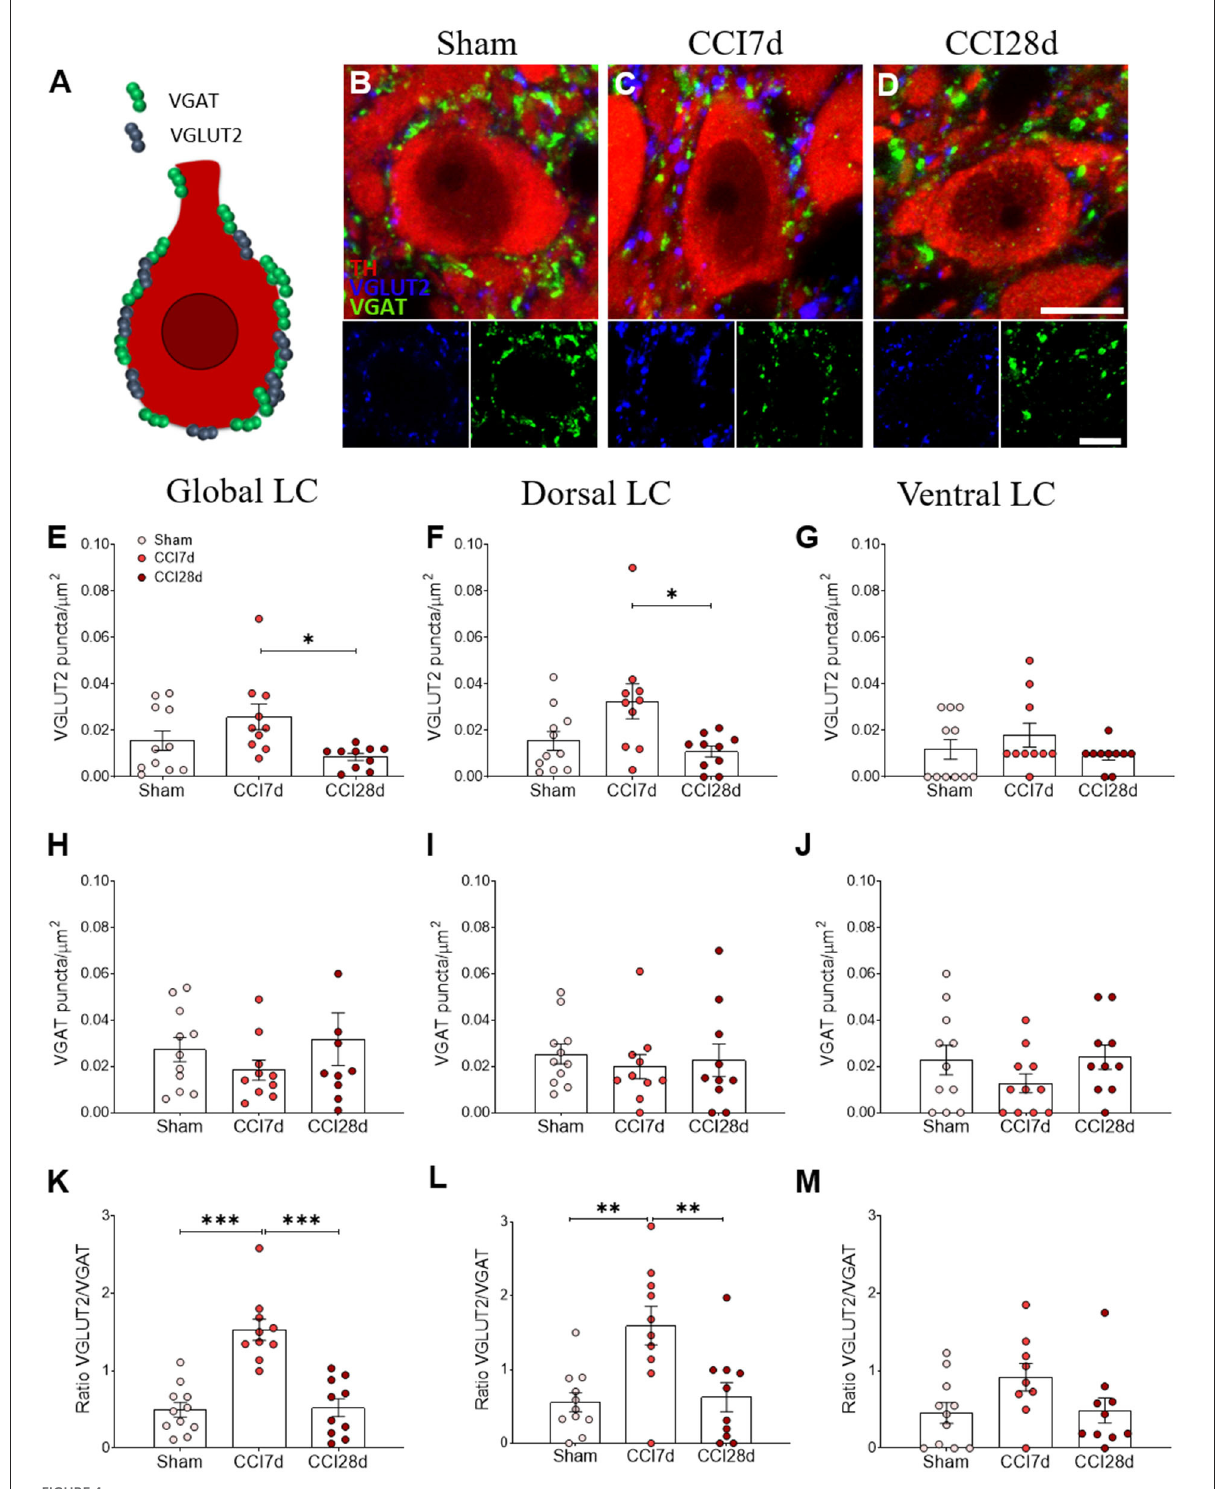
FIGURE4 Perisomatic puncta expressing VGLUT2 and VGAT in LC neurons of neuropathic pain rats. (A–D) Representative confocal images showing perisomatic density of puncta expressing VGLUT2 and VGAT in the LC of (B) Sham, (C) CCI7d, and (D) CCI28d rats (TH red; VGLUT2 blue; VGAT green: scale bar, 10 µ m). (E–G) Quantification of the VGLUT2 expression in the (E) global, (F) dorsal, and (G) ventral LC. (H–J) Quantification of VGAT expression in the (H) global, (I) dorsal, and (J) ventral LC. (K–M) Representation of the ratio of VGLUT2/VGAT puncta in the (K) global, (L) dorsal, and (M) ventral LC. The data are presented as the mean ± SEM of the number of the puncta/ µ m 2 (obtained from 30 to 35 neurons from three LC sections per rat): * p < 0.05, ** p < 0.01, *** p < 0.001 vs. the corresponding group, one-way ANOVA followed by a Tukey’s